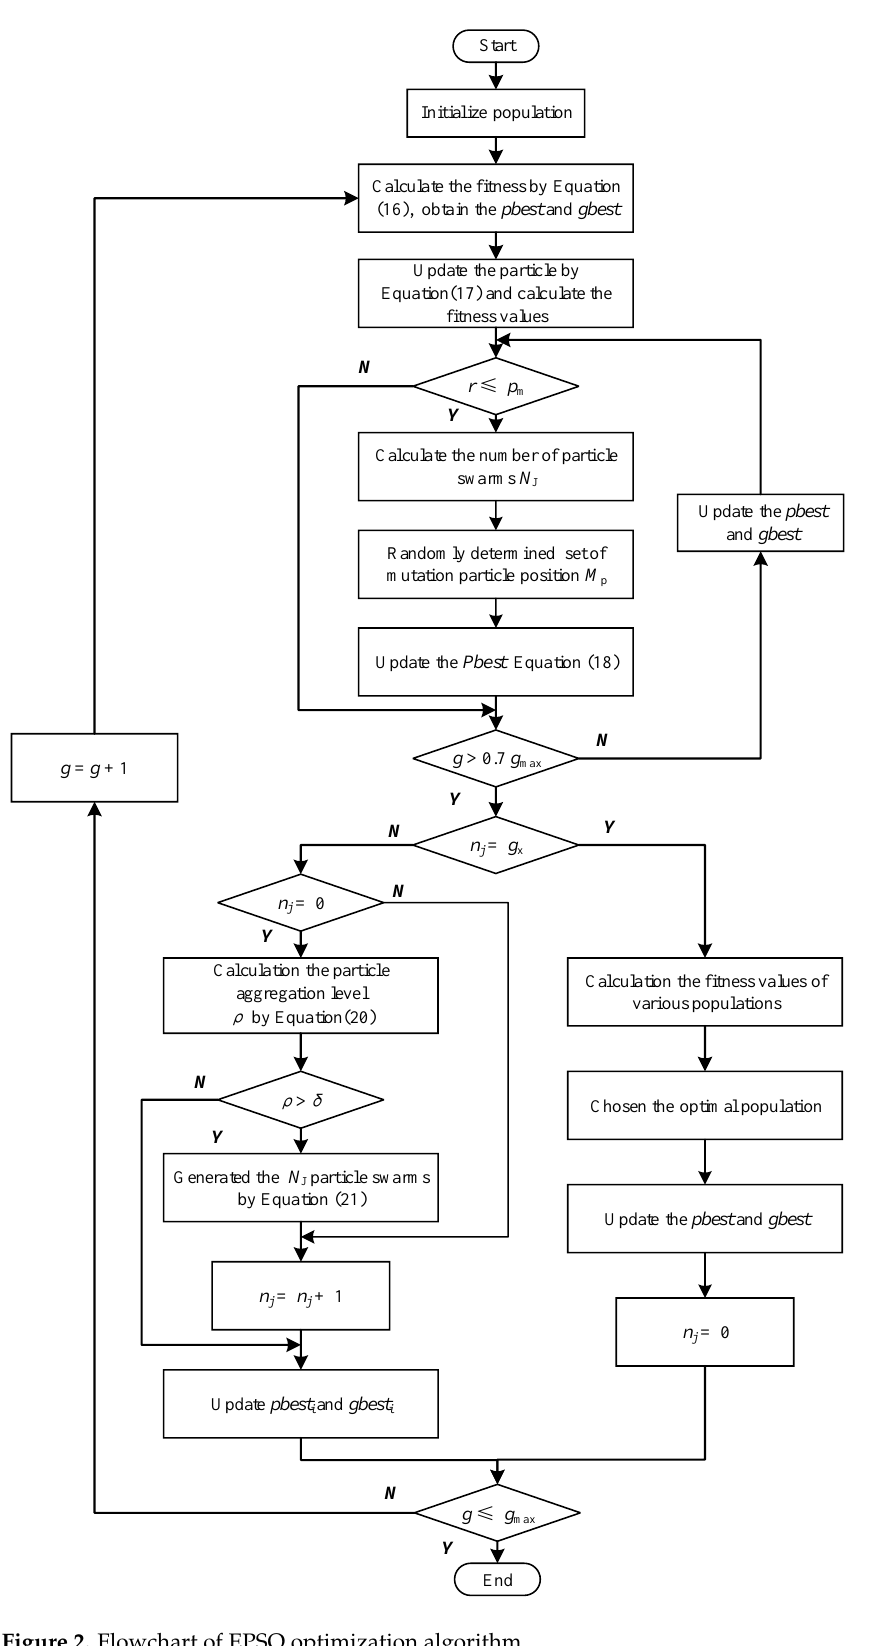
Figure 2. Flowchart of EPSO optimization algorithm.